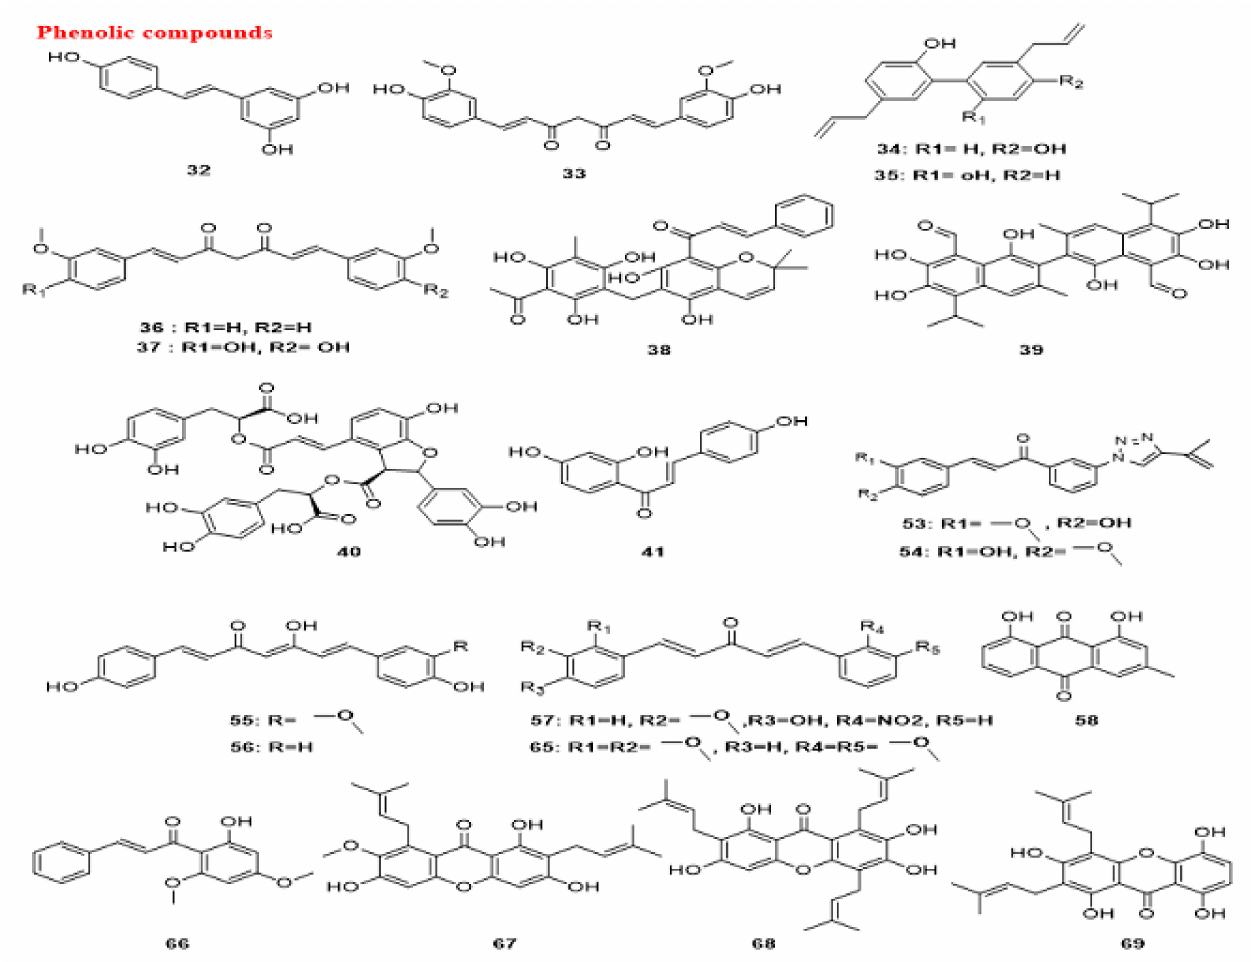
Figure 11. Chemical structures of phenolic compounds. Resveratrol (32), curcumin (33), honokiol (34), magnolol (35), bis-dihydroxy-curcumin (36), tetrahydrocurcumin (37), rottlerin (38), gossypol (39), salvianolic Acid B (40), isoliquiritigenin (41), epigallocatechin gallate (52), tria- zolyl curcumins (53, 54), demethoxycurcumin (DMC) (55), bisdemethoxycurcumin (BDMC) (56), WZ35 (57), chrysophanol (58), B19 (65), flavokawain B (66), α -mangostin (67), garcinone E (68), gartanin (69). The images were prepared using ChemDraw Professional